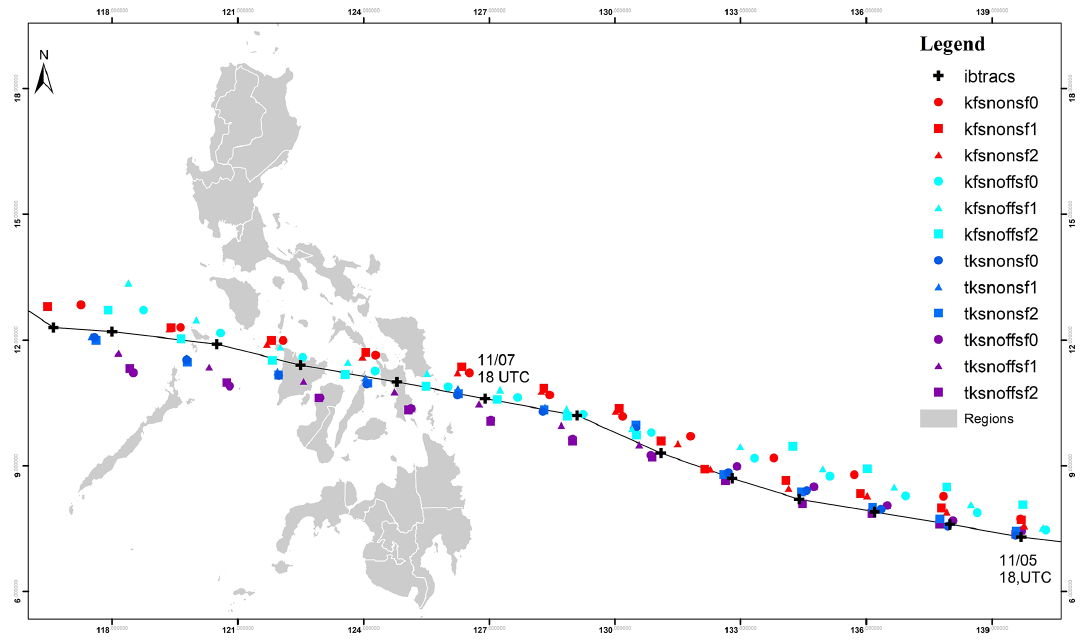
Figure 2. Simulated tracks compared with IBTrACS and the sensitivity experiments classified according to experiment groups: Kain–Fritsch (KF) convection scheme, Tiedtke (TK) convection scheme, with spectral nudging (snON), without nudging (snOFF), surface flux option 0 (sf0), option 1(sf1), and option 2 (sf2).